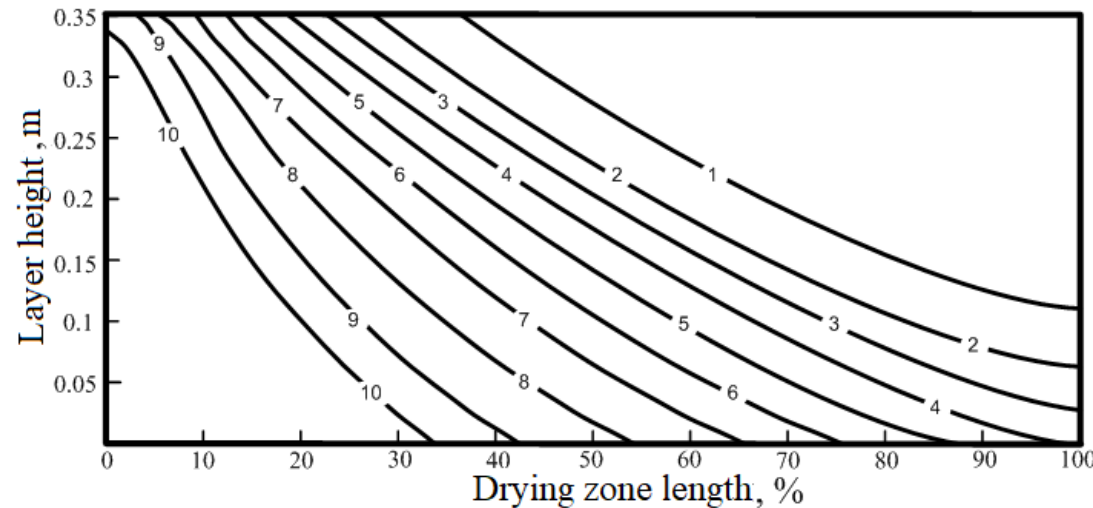
Figure 13. Parametric family of isolines showing the variable u -moisture content of pellets.